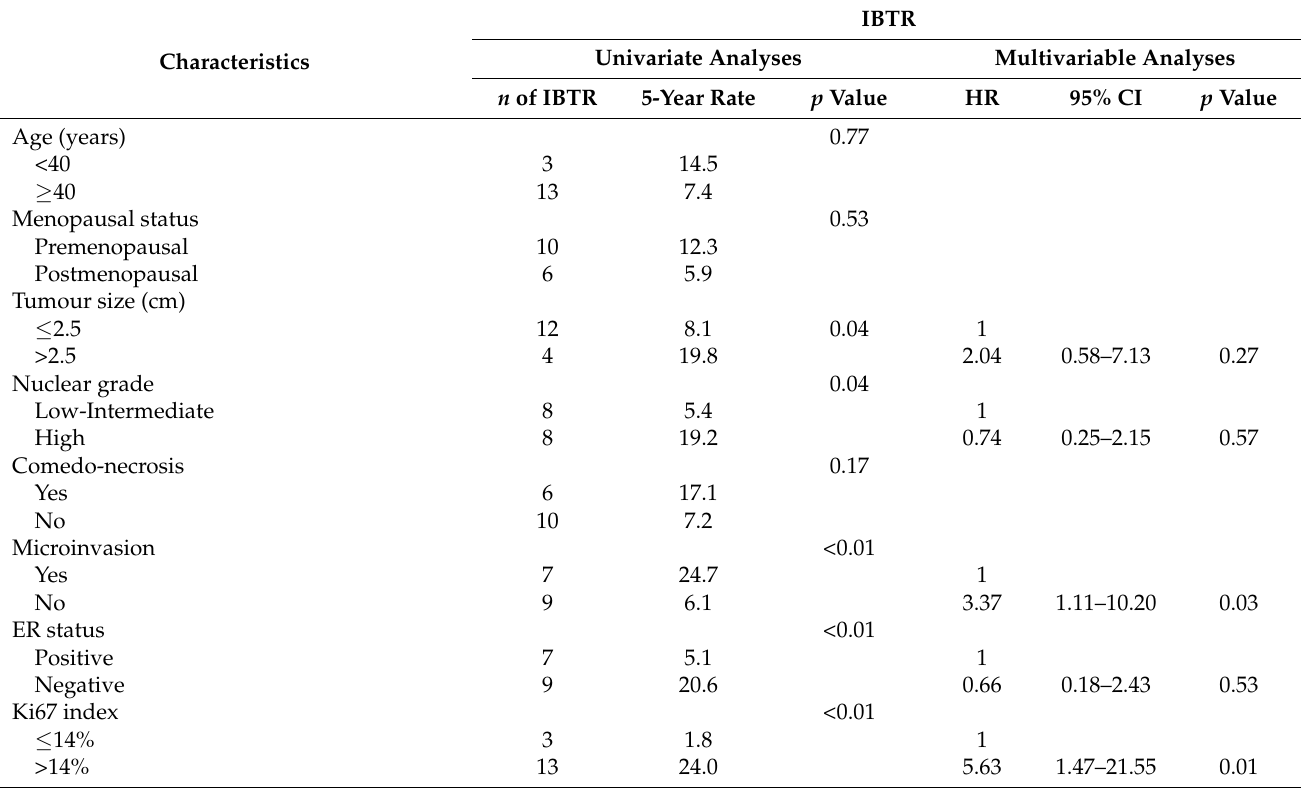
Table 2. The univariate and multivariable analyses for IBTR in training group.